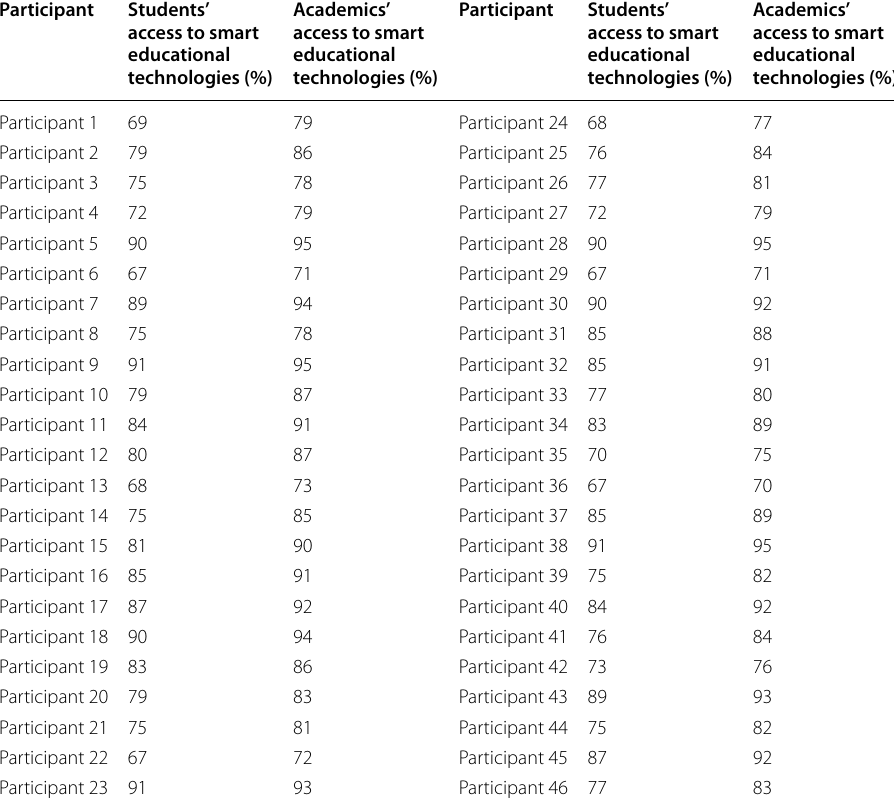
Table 3 Students and academics’ access rate to smart educational technologies